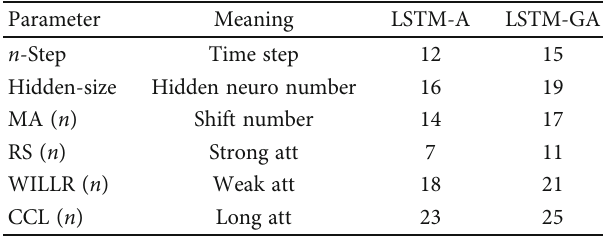
Table 1: Parameter tuning correspondence.